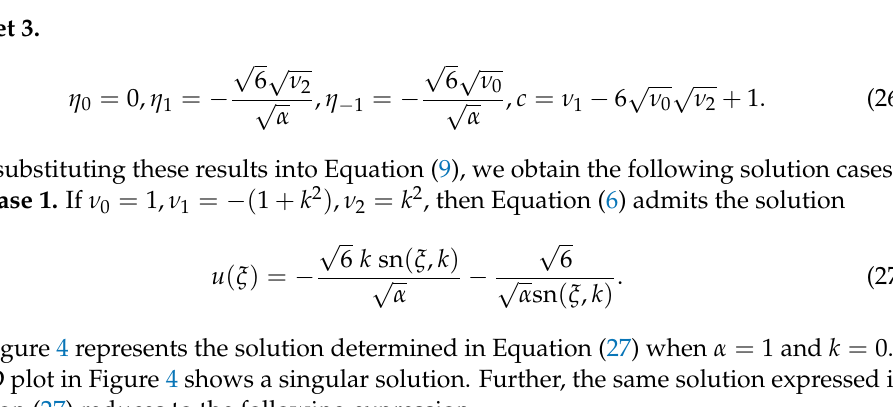
Figure 3. The graphs ( a , b ) are the 3D plots of the positive solutions (24), (25), respectively. In ( a ), k = 0.8.